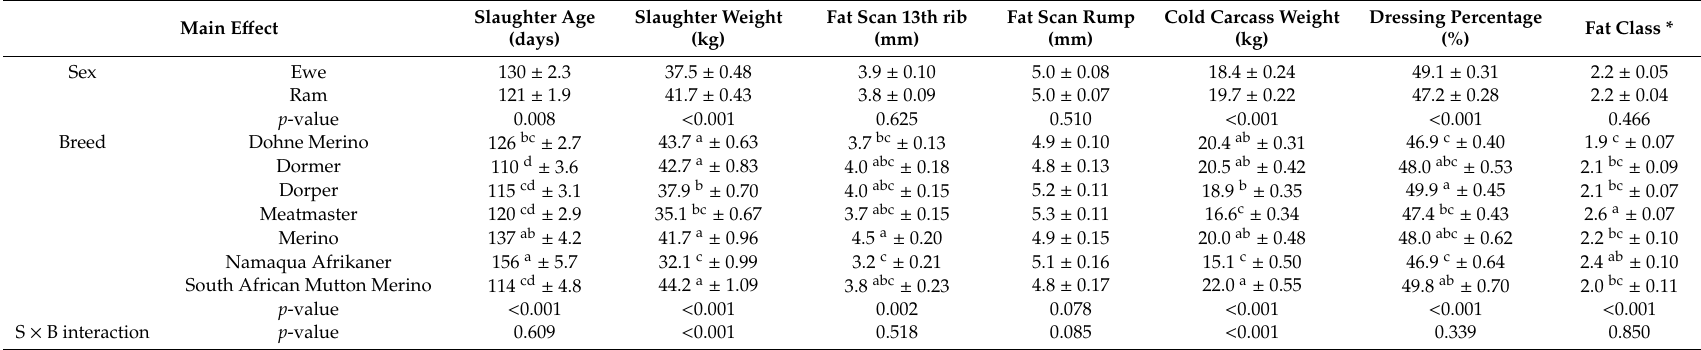
Table 3. Slaughter characteristics of A2 carcasses depending on the lamb sex and breed at a fat scan thickness of 5.2 mm, expressed as the least square means ± standard error.